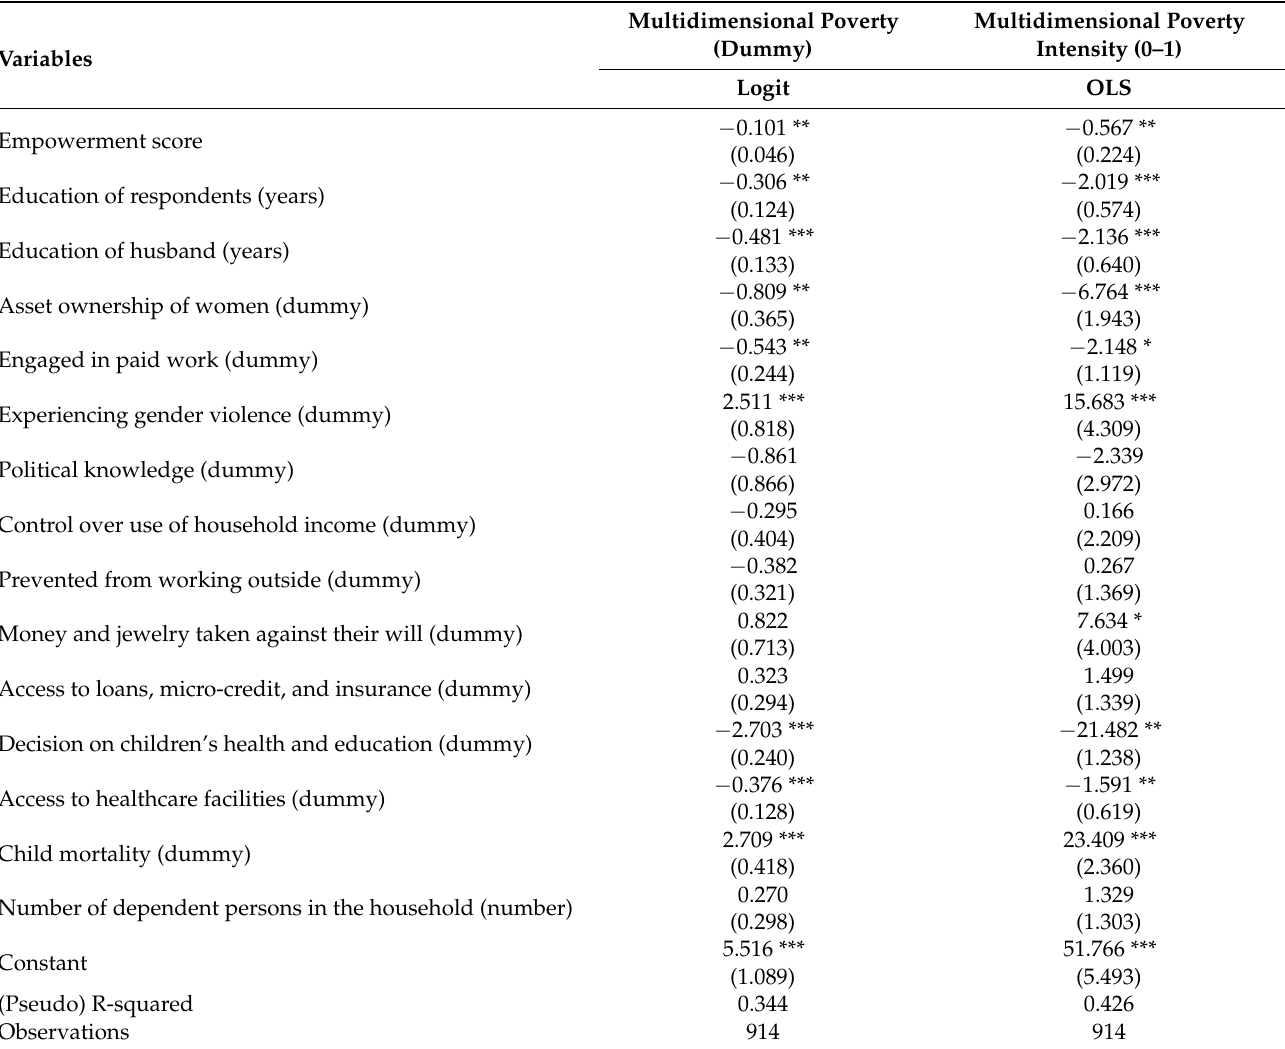
Table 7. Effect of women’s empowerment on multidimensional